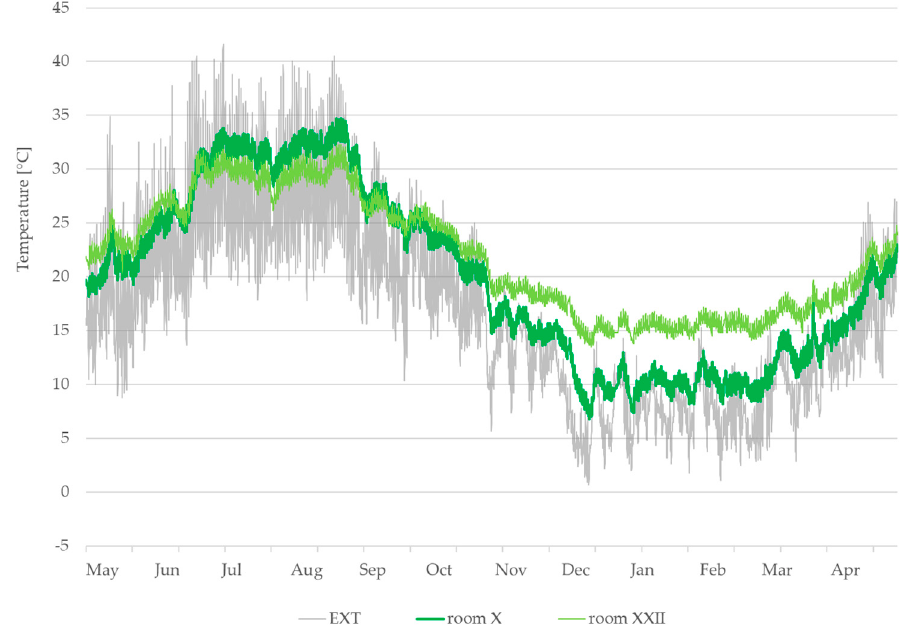
Figure 17. Time profiles of temperature T values measured from May 2012 to April 2013 in rooms X and XXII, and outdoors (EXT).